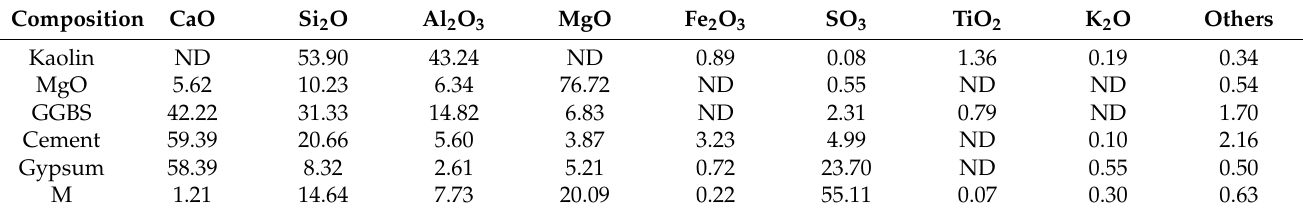
Table 1. Oxide composition and percentage content of main